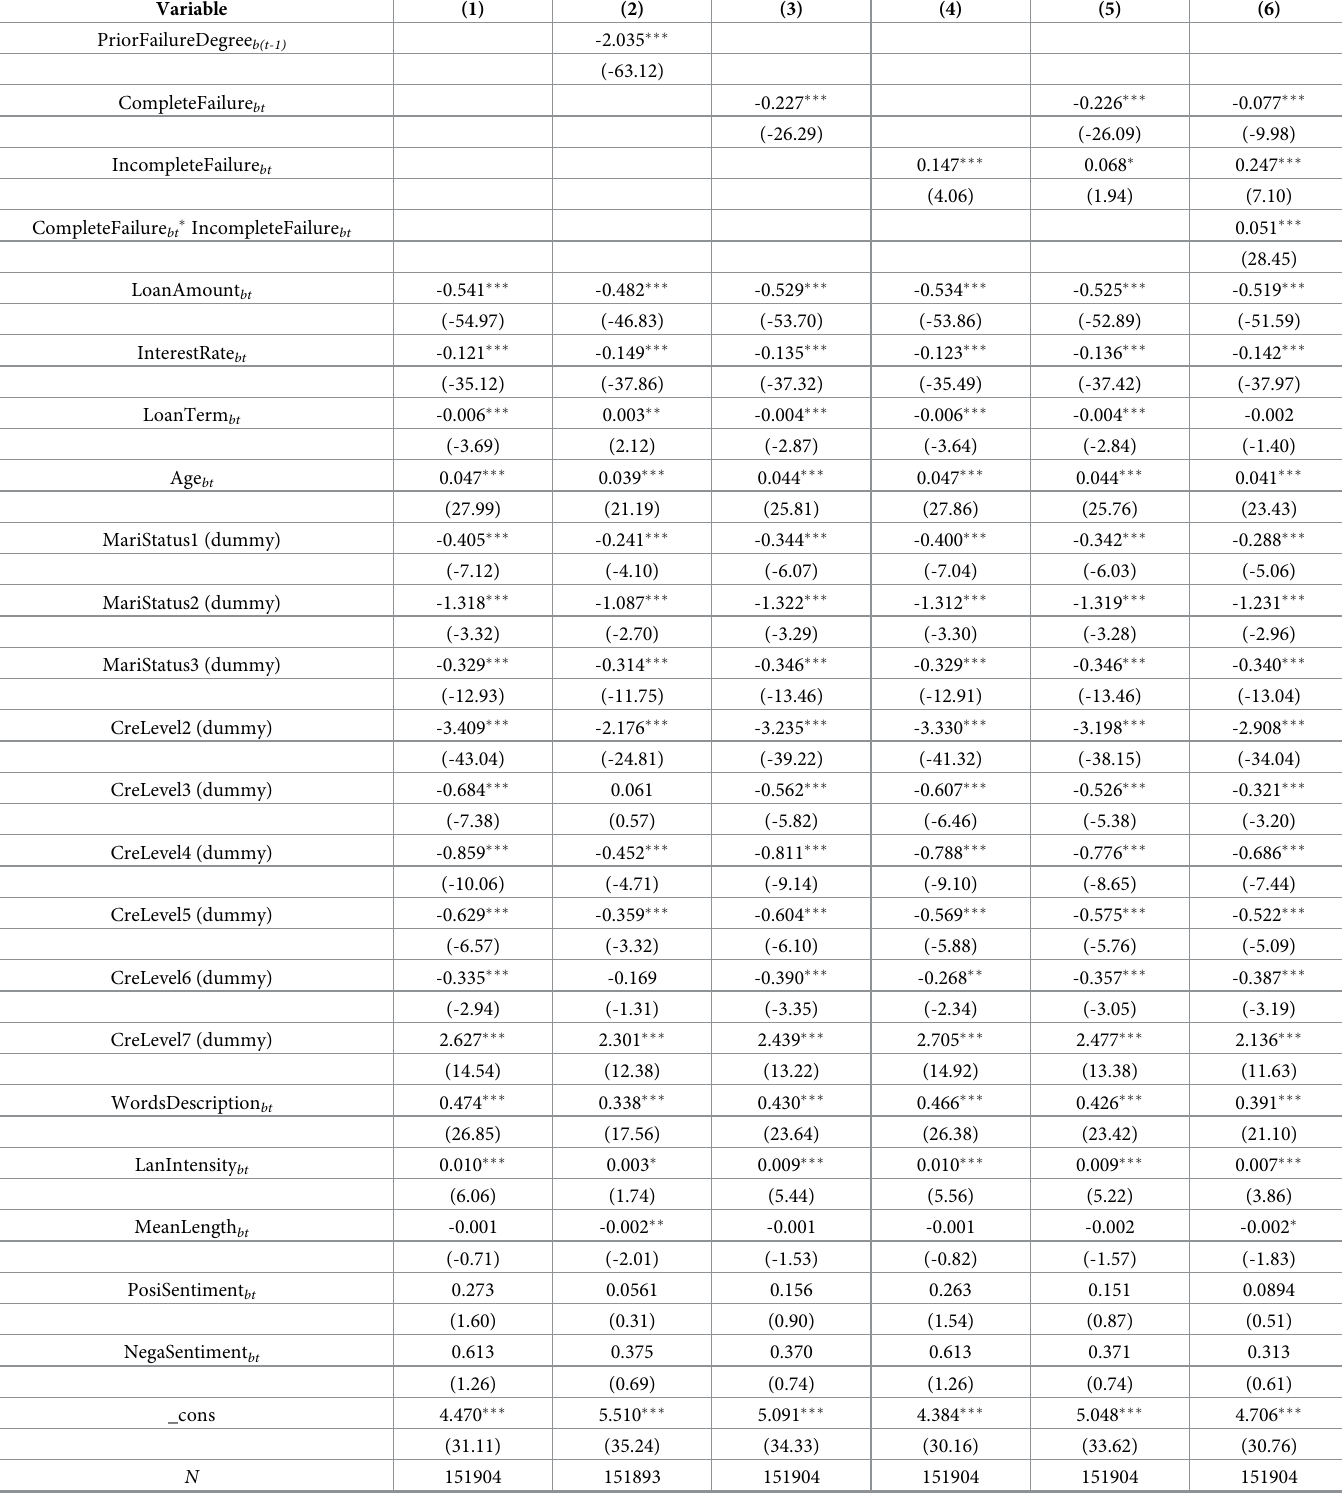
Table 5. Logistic regression results for the effect of failure degree on funding